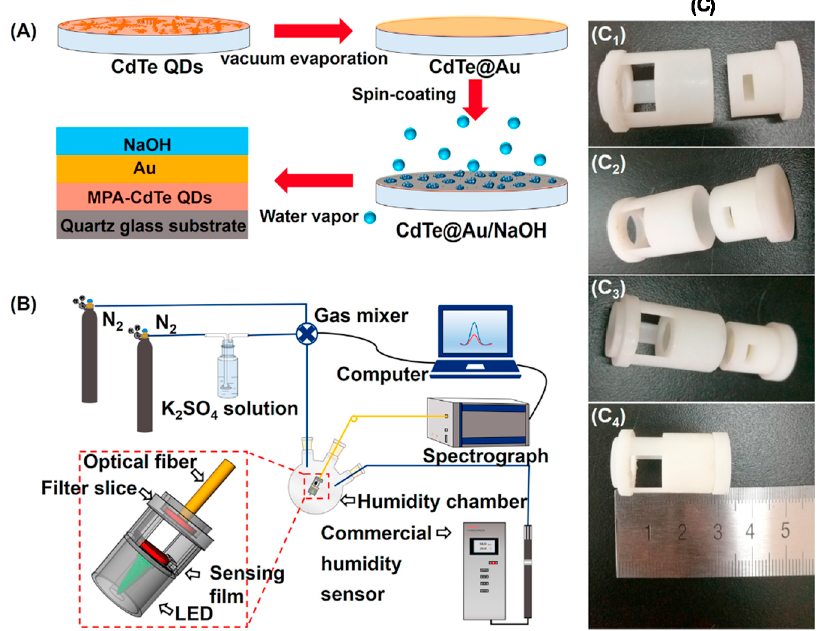
Figure 30. Point sensor. ( a ) Fabrication process of the sensing film. ( b ) Experimental setup. ( c ) Photographs of the device. Reprinted with permission from ref. [154]. Copyright 2019 Elsevier .